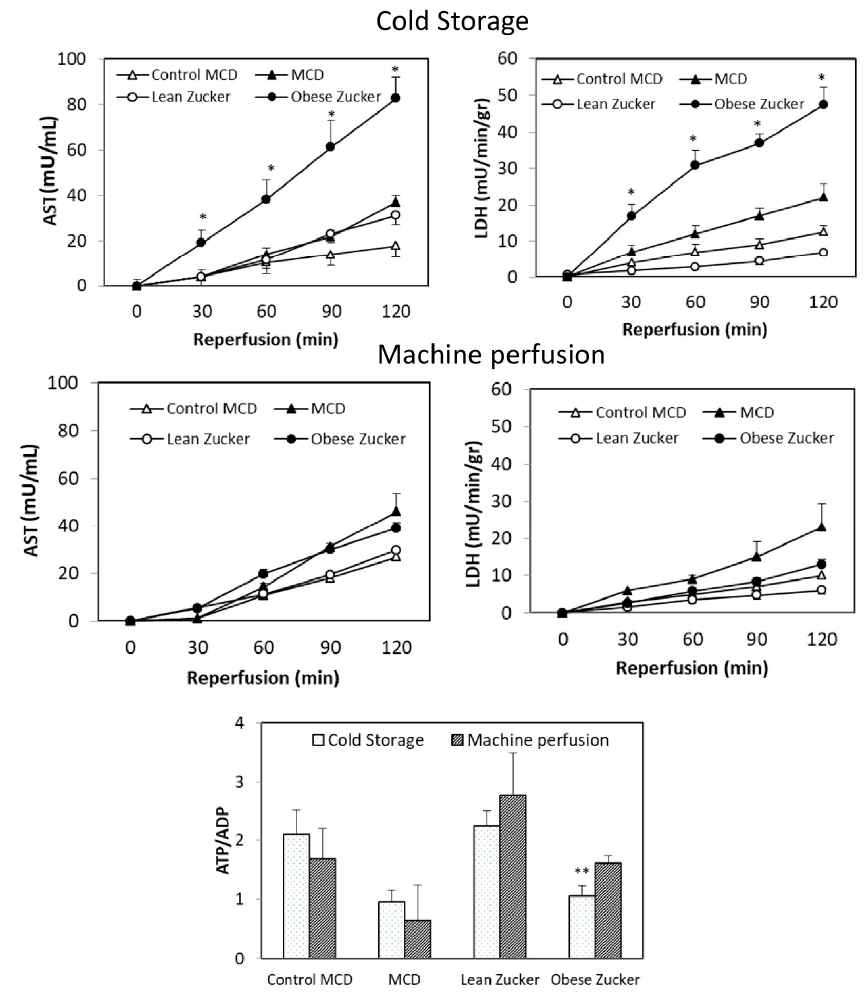
Figure 5. Effects of static CS or dynamic MP in MCD and Zucker rats. AST and LDH release and the ATP/ADP tissue ratio at the end of reperfusion. Livers were submitted to CS or MP; after 6 h preservation, 2 h reperfusion was performed. The values are reported as means ± SE, n = 7/group. *